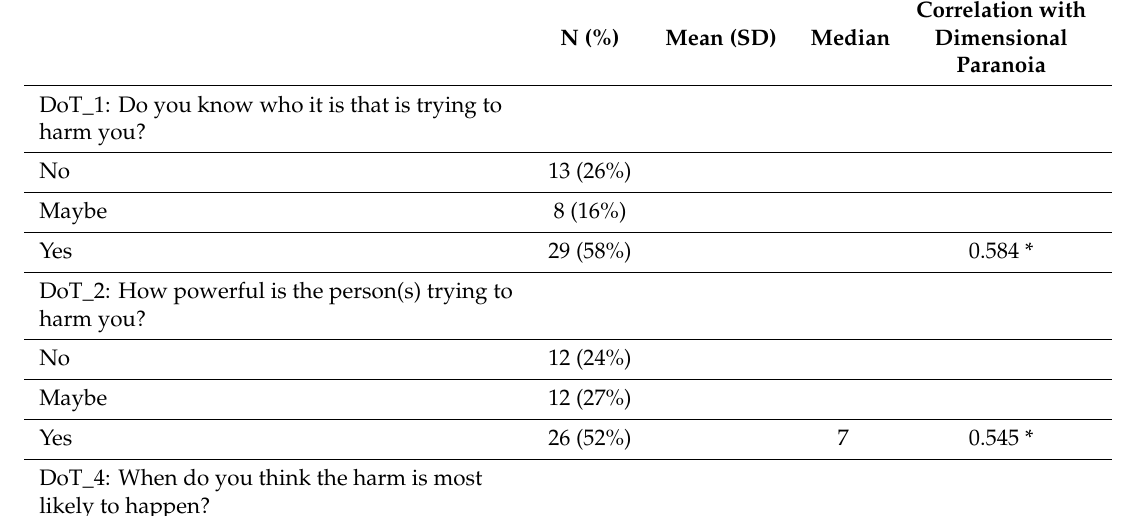
Correlation with N (%) Mean (SD) Median Dimensional